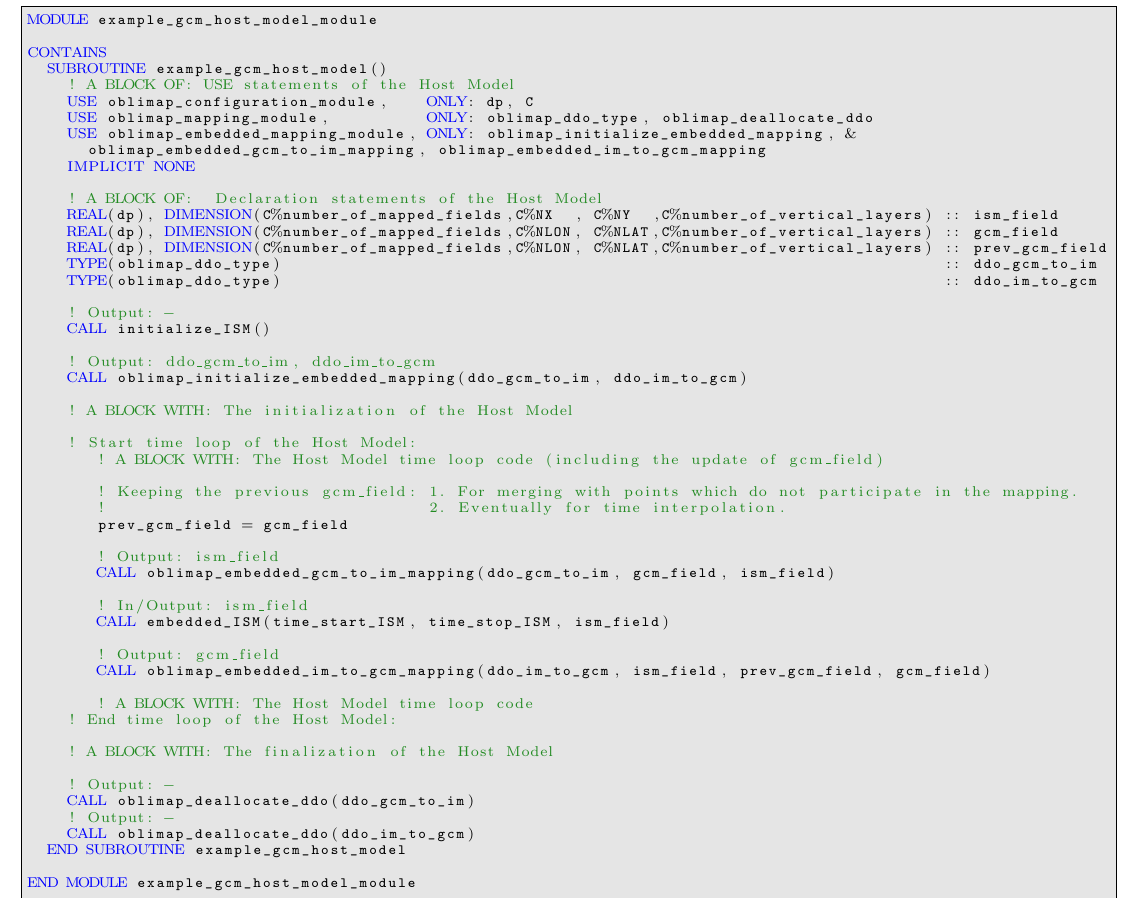
Figure 5. A schematic outline shows how to use the OBLIMAP API for embedding an ISM with OBLIMAP in a GCM host model. The initialize_ISM and embedded_ISM are hypothetic ISM routines that are not part of OBLIMAP but embed the